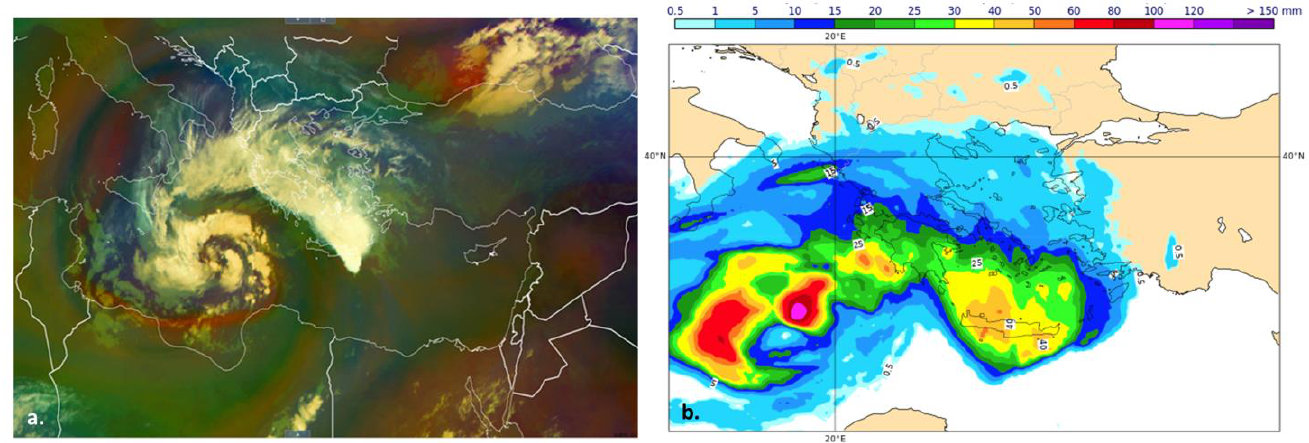
Figure 3. ( a ) AIR MASS RGB image for 28/06 UTC and ( b ) accumulated rain 24 h (mm) from 28/00 UTC to 29/00 UTC as derived by HSAP products of EUMETSAT.